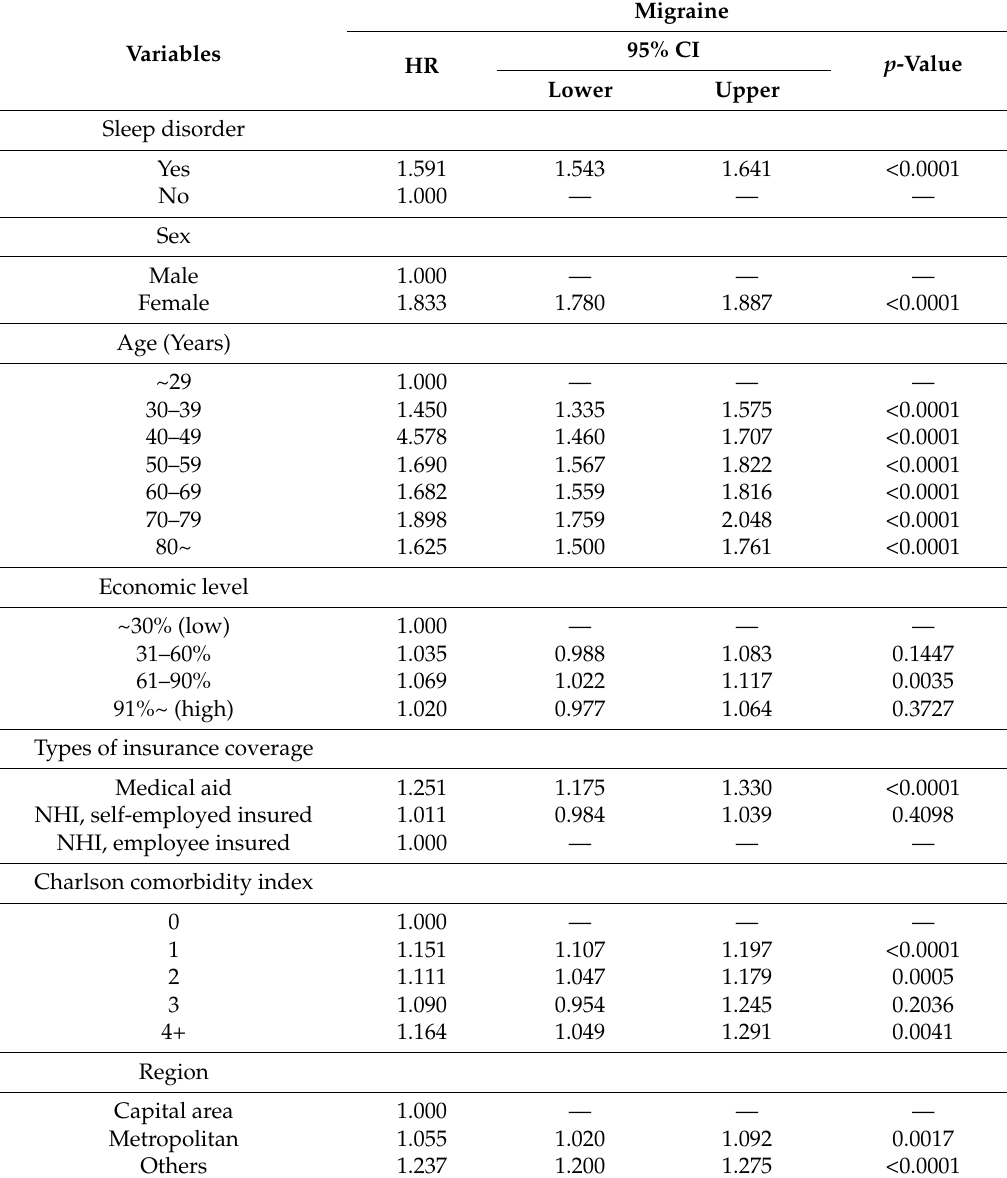
Table 2. Results of survival analysis for the association between sleep disorder and